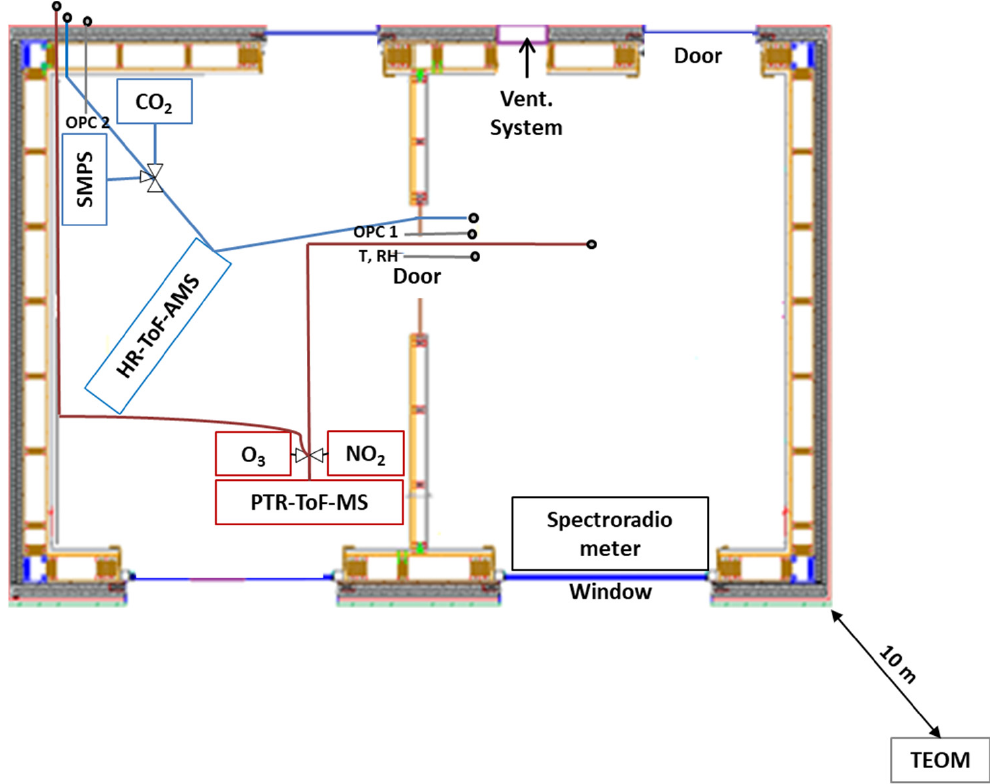
Figure 1. Schematic of the instrumentation room (left) and the experimental room (right).